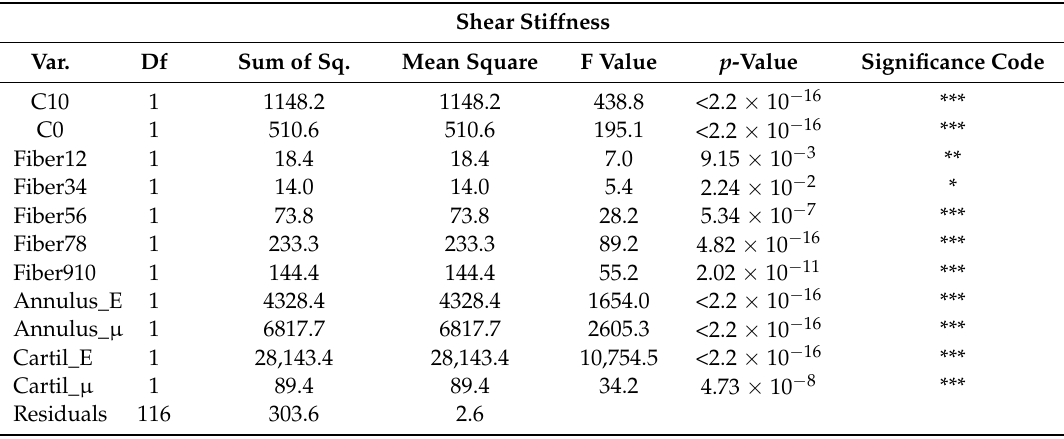
Table 15. ANOVA table for a shear stiffness linear model. Shear Stiffness